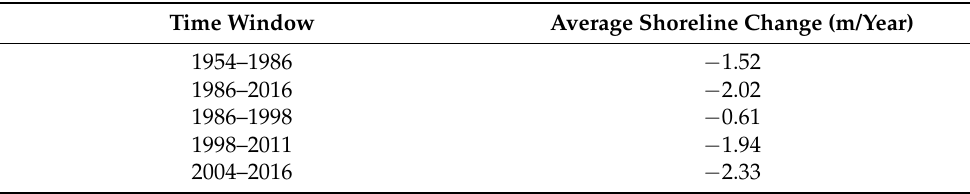
Table 1. Shoreline change rate, averaged along the Trigno river mouth stretch of coast, for either 30 year or 12 year time windows. Time